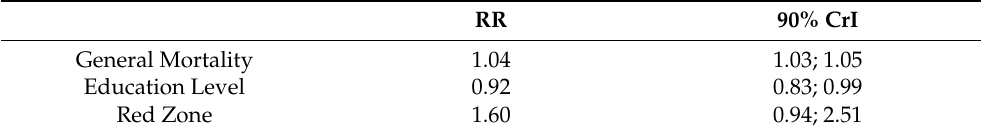
Table 2. Results of the Bayesian ecological regression model on COVID-19 mortality: adjusted